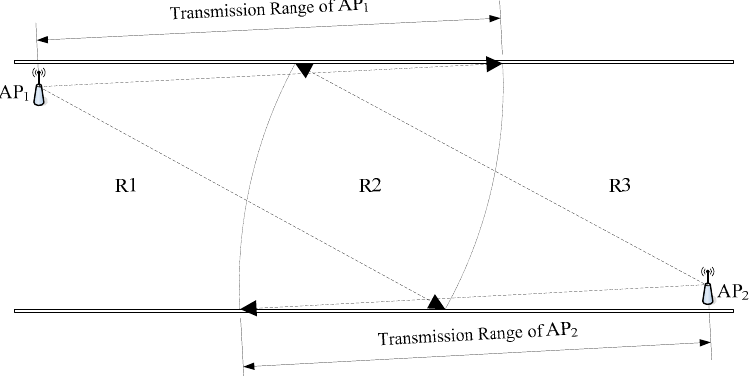
Figure 6. Diagram of a general underground tunnel wireless communication network.